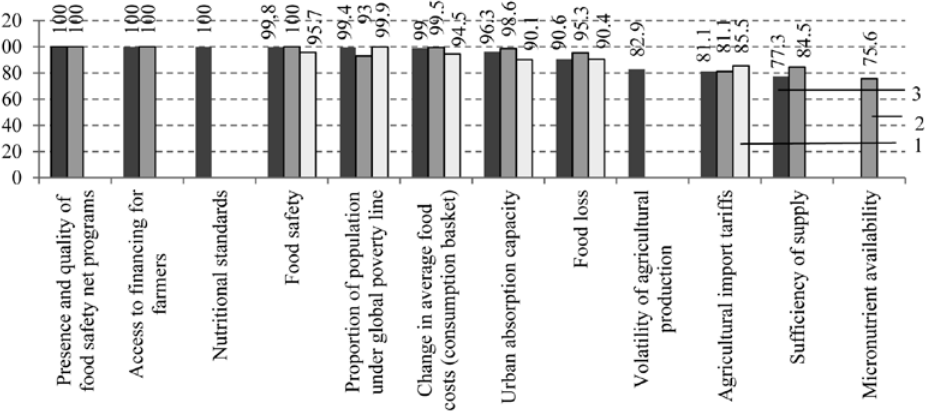
Figure 1. Food security strengths by countries, 2019: 1 – Ukraine; 2 – Romania; 3 – Poland